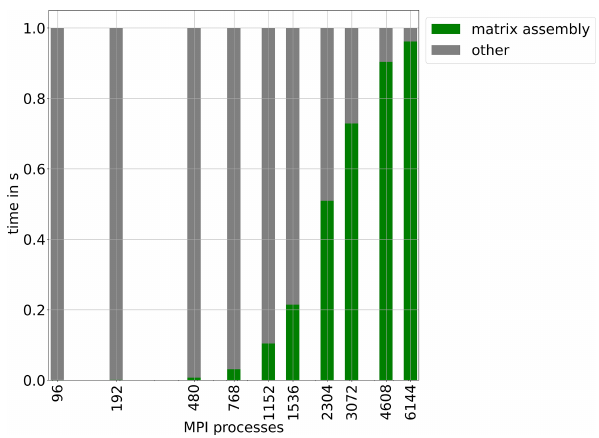
Figure 11. Percentage of computation time spent in matrix assem- bly versus the remaining computations in mass transport